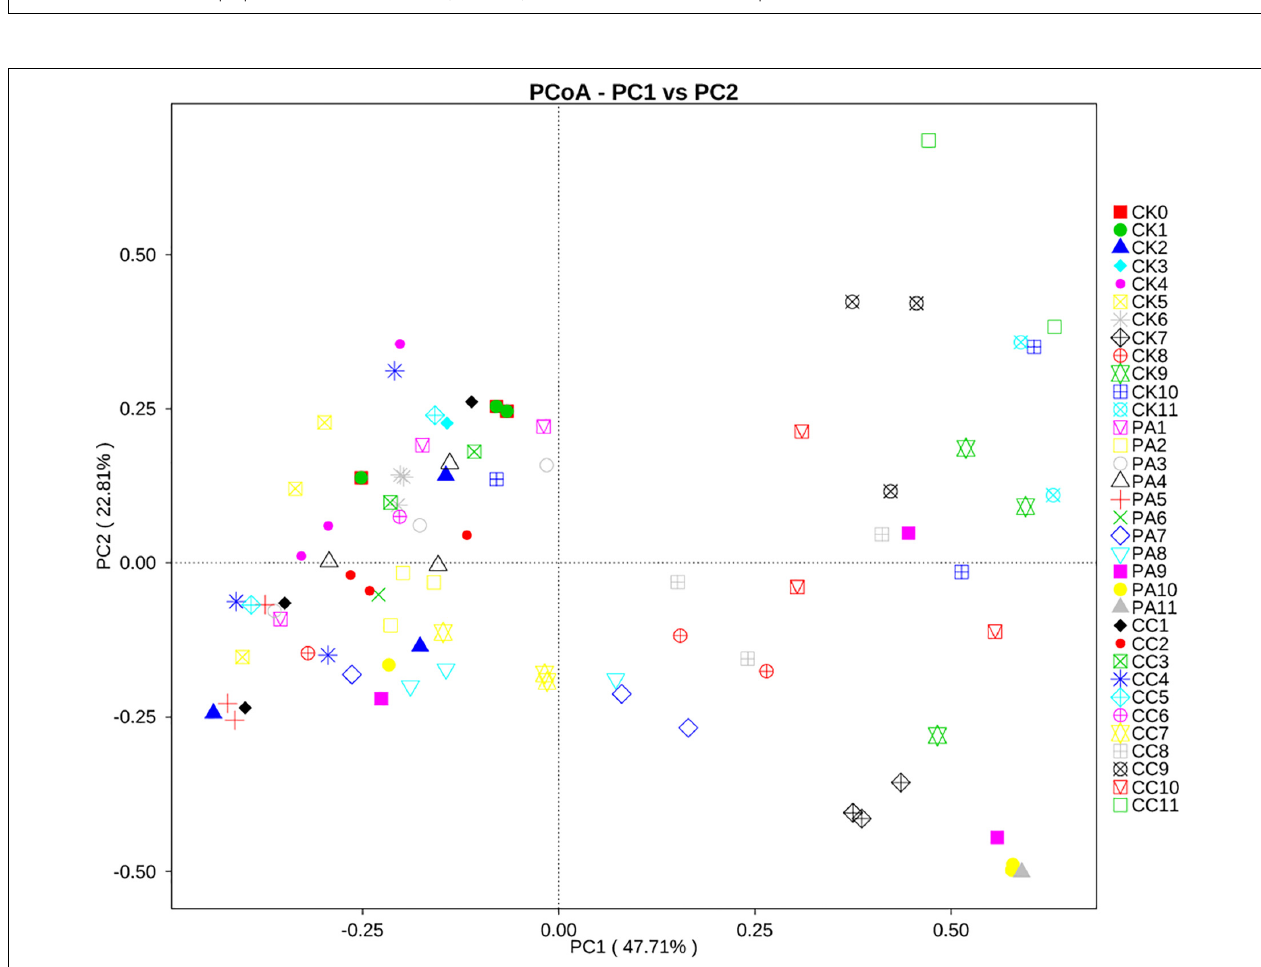
FIGURE 4 | Principal coordinate analysis (PCoA) of distribution of fungi in stored maize. CK0, raw maize; CK1–CK11, stored maize in control group at 1–11 months; PA1–PA11, stored maize treated with propionic acid at 1–11 months; CC1–11, stored maize treated with complex essential oils.